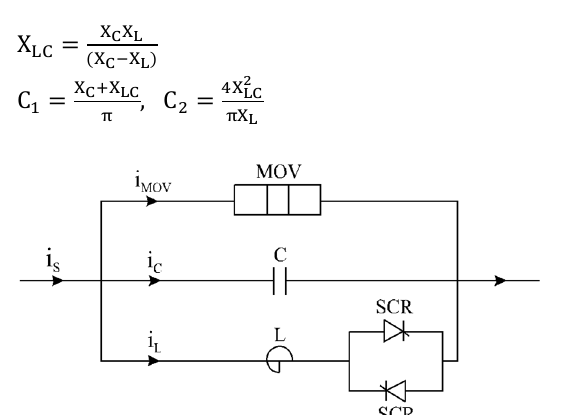
Fig. 1: Thyristor Controlled Series